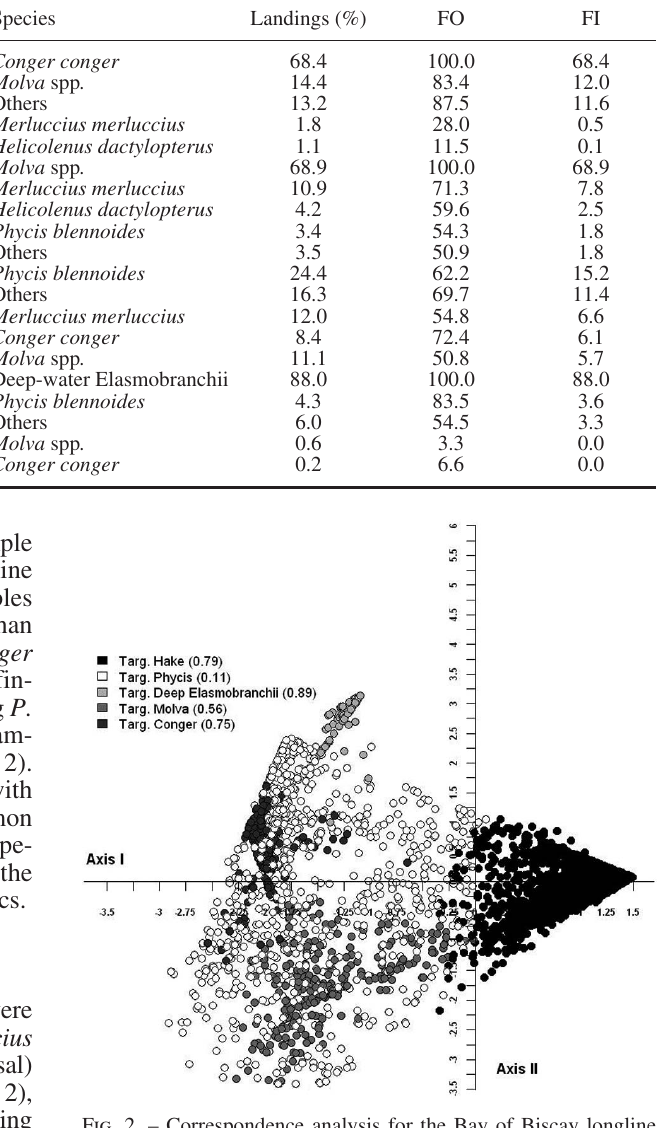
Fig . 2. – Correspondence analysis for the Bay of Biscay longline trips identified according to the cluster or fishing tactic to which they were